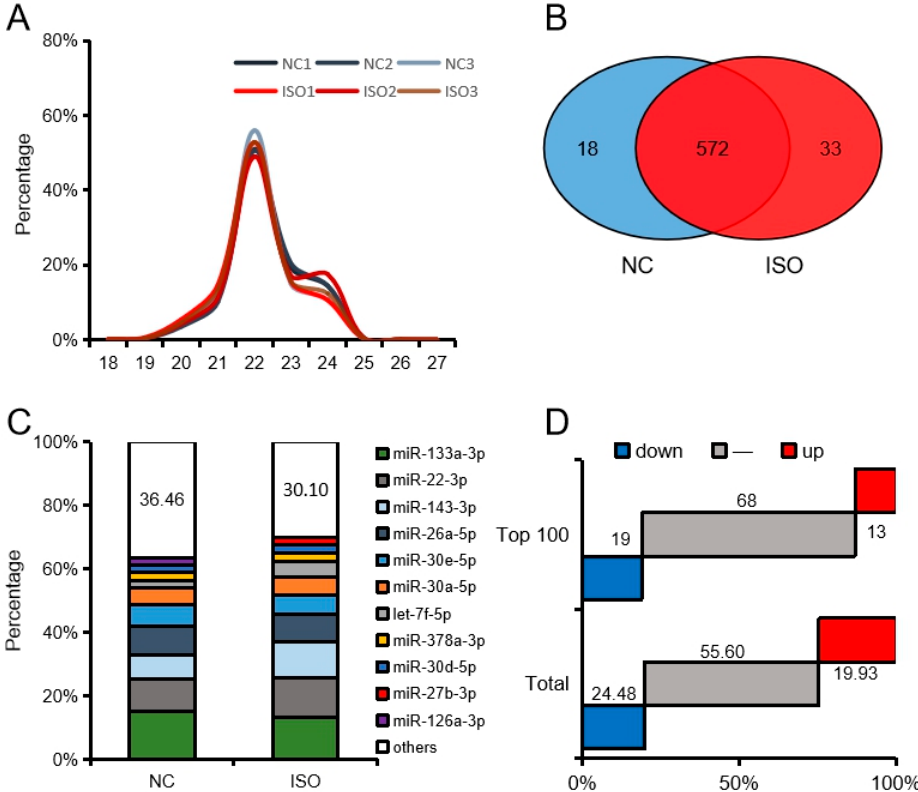
Figure 2. Expression characteristics of rat myocardial miRNA. ( A ) Size distribution of miRNAs. ( B ) The Venn diagrams represent the number of expressed miRNAs. ( C ) Composition of highly expressed miRNAs. ( D ) Differential expression of miRNAs (down: Fold change ≤ 2 / 3, up: Fold change ≥ 3 /